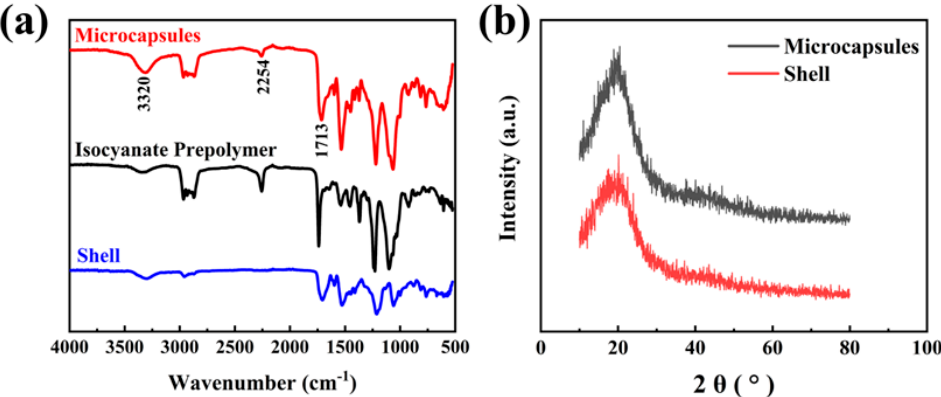
Figure 3. ( a ) FTIR spectra of isocyanate prepolymer, shell and microcapsules. ( b ) XRD diagram of microcapsules.